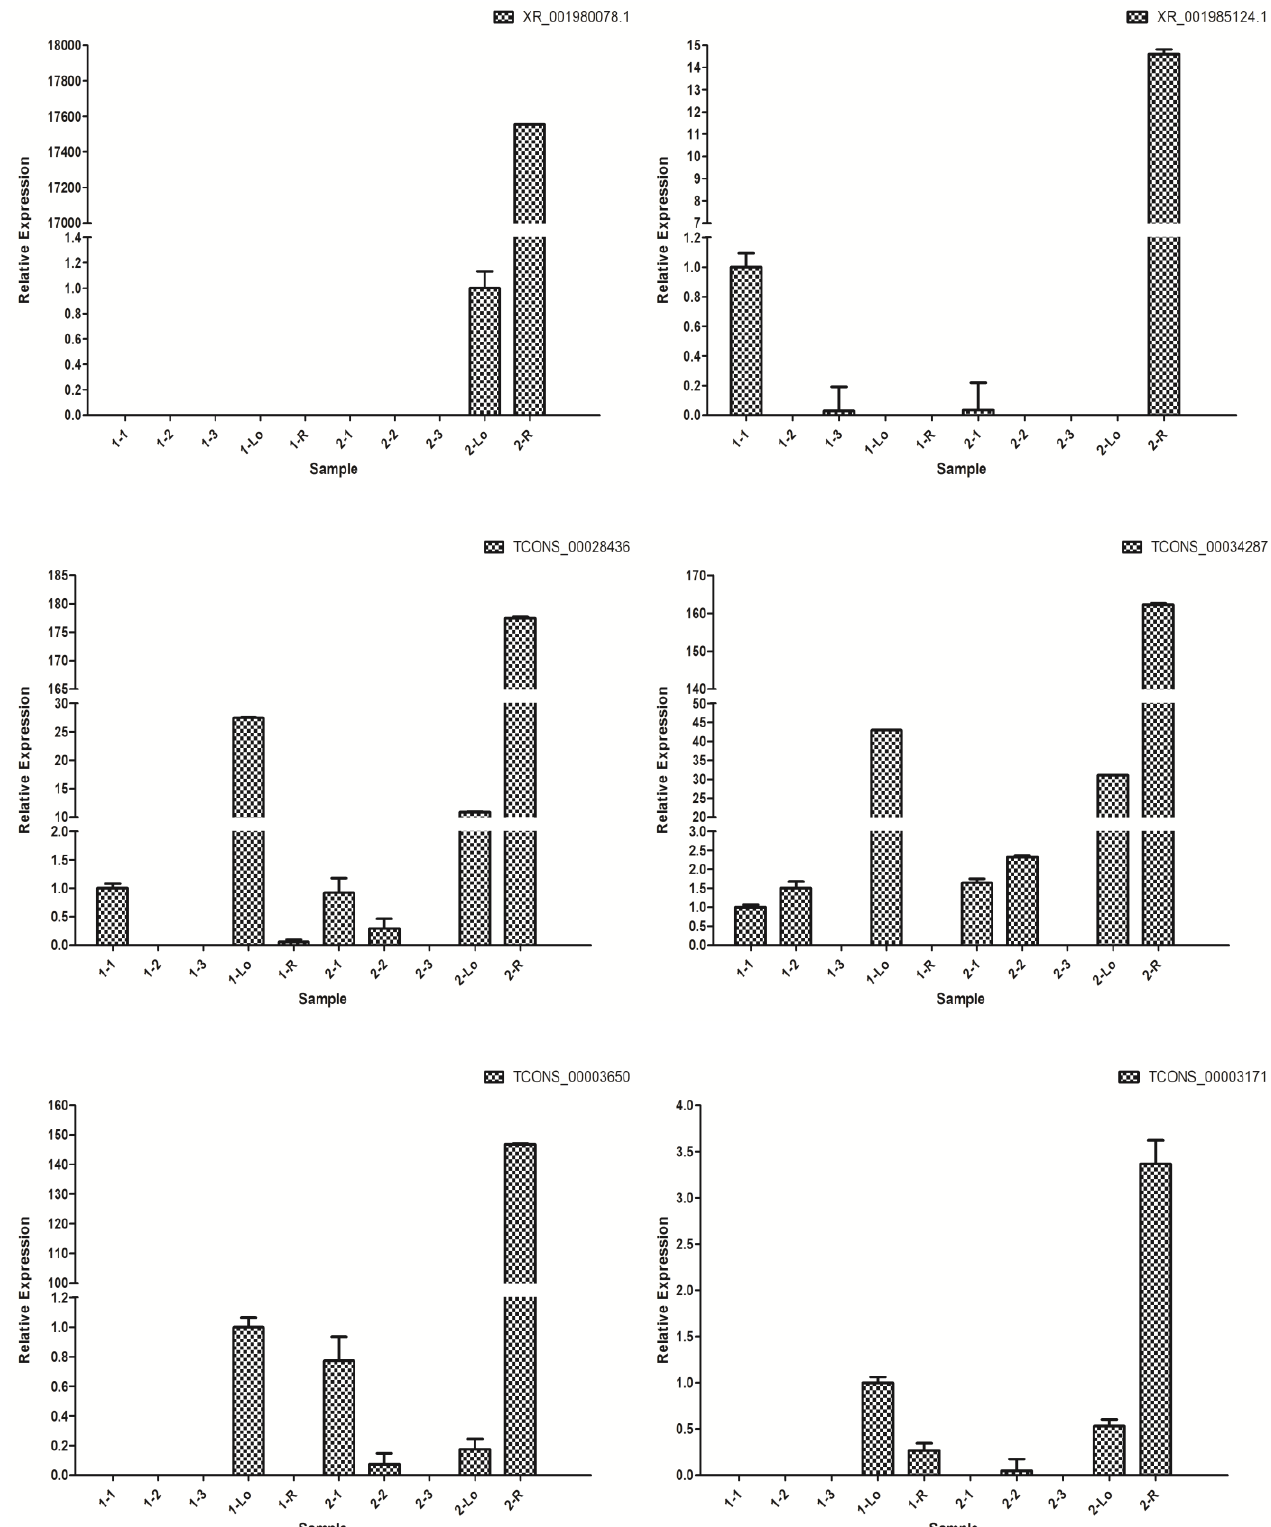
Figure 4. Results of target gene q RT-PCR. 1-1, 2-1 represented diameter at breast height of the trunk; 1-2, 2-2 represented the middle of the trunk; 1-3, 2-3 represented upper part of the trunk; 1-Lo, 2- Lo represented the leaves; and 1-R, 2-R represented the roots of E. grandis .